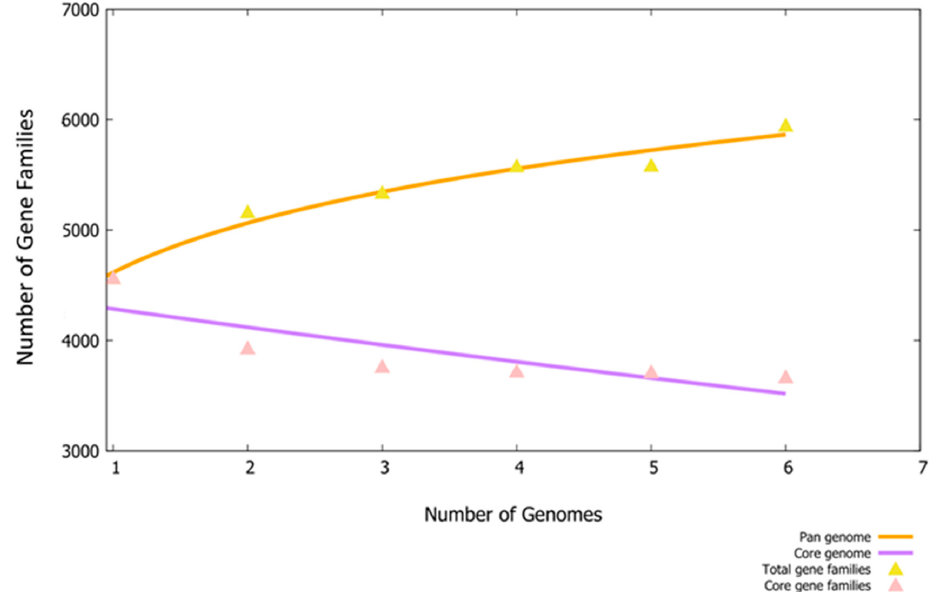
Figure 3. Pan-genome analysis of E. xiangfangensis. The plots demonstrate the number of gene families in each strain of the pathogen.